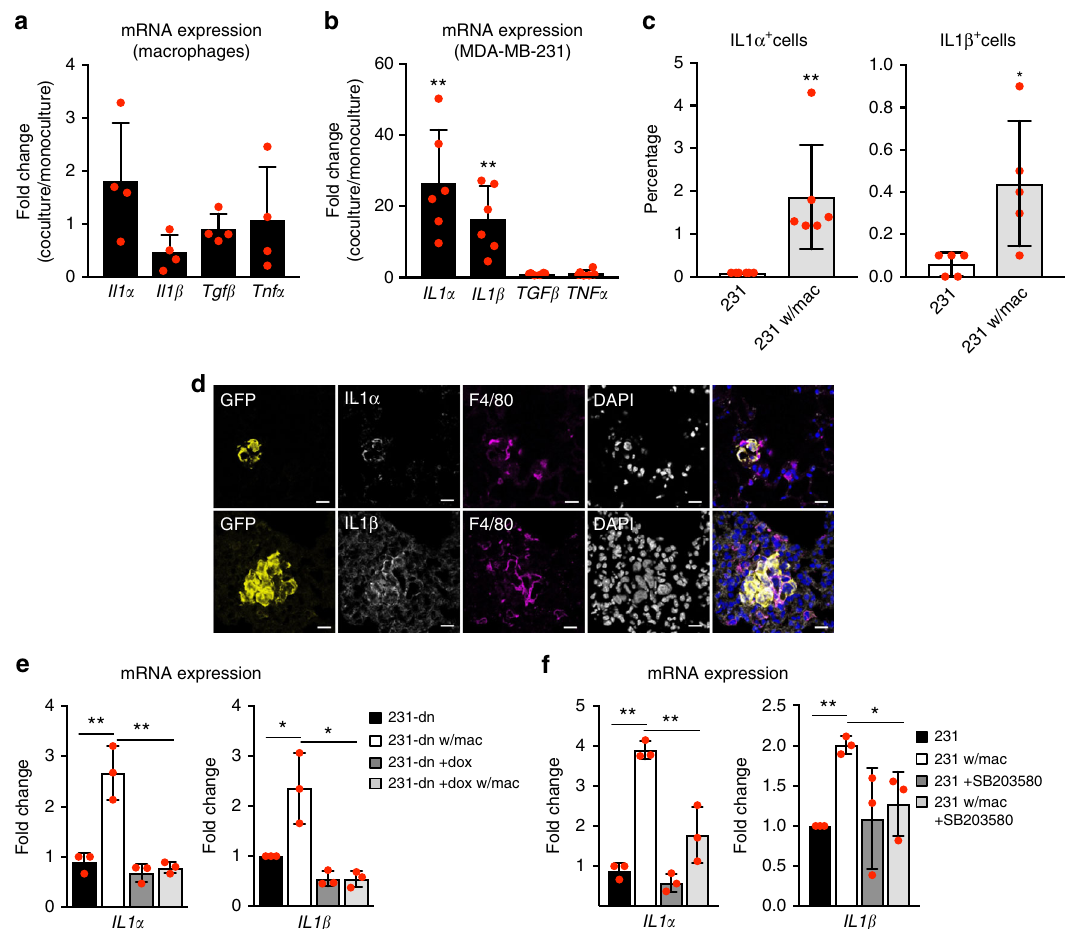
Fig. 4 Co-culture with macrophages increases IL1 α and IL1 β expression in MDA-MB-231 cells in a TAK1-dependent manner. a qPCR analysis of Il1 α , Il1 β , Tgf β , and Tnf α expression in macrophages cultured in the presence or absence of MDA-MB-231 cells for 5 days. b qPCR analysis of IL1 α , IL1 β , TGF β , and TNF α expression in MDA-MB-231 cells cultured in the presence or absence of macrophages for 5 days. c Percentage of IL1 α -positive (left) and IL1 β -positive (right) cells in GFP-tagged MDA-MB-231 monocultures and GFP-tagged MDA-MB-231 cells cultured with macrophages. d Immuno fl uorescent staining of lungs dissected from mice injected with GFP and luciferase-tagged MDA-MB-231 cells. Representative examples of images taken from three immunostainings of two independent experiments are shown. GFP (yellow), macrophage marker F4/80 (magenta), IL1 α or IL1 β (white), DAPI (gray in single channel, blue in merge image) are shown. Scale bar = 20 μ m. e qPCR analysis of IL1 α and IL1 β expression in MDA-MB-231 cells stably expressing doxycycline-inducible dominant-negative TAK1 (TAK1-dn), grown in co-culture with macrophages for 3 days in the presence or absence of doxycycline (doxy). f qPCR analysis of IL1 α and IL1 β expression in MDA-MB-231 cells cultured in the presence or absence of macrophages and treated or not with 1 μ M SB203580. In a , b , e , and f , GFP-tagged MDA-MB-231 cells were used, and macrophages and MDA-MB-231 cells were separated by FACS for RNA extraction. Graphs show means ± SD of three ( e , f ), four ( a ), fi ve ( c , right panel) and six ( b , c , left panel) independent experiments. Statistical signi fi cance analyzed by unpaired two-tailed Student ’ s t test * p ≤ 0.05; ** p ≤